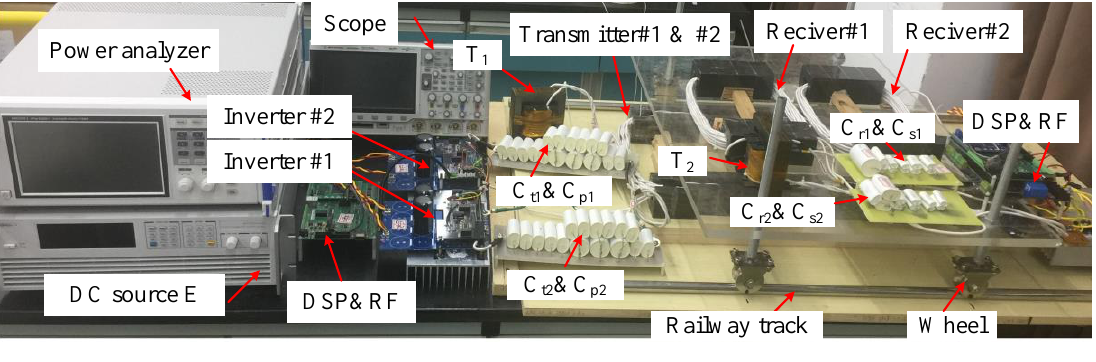
Figure 9. Laboratory setup. Table 1. Specifications and circuit parameters of WPT prototype.